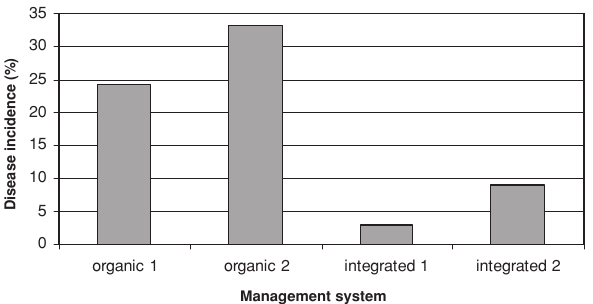
Figure 2: Efficacy of standard and reduced spray programmes on cherry leaf spot on leaf in integrated and organic sour cherry orchards in 2009 (LSD = 4.8 – integrated; LSD = 7.6 – organic). 0.05